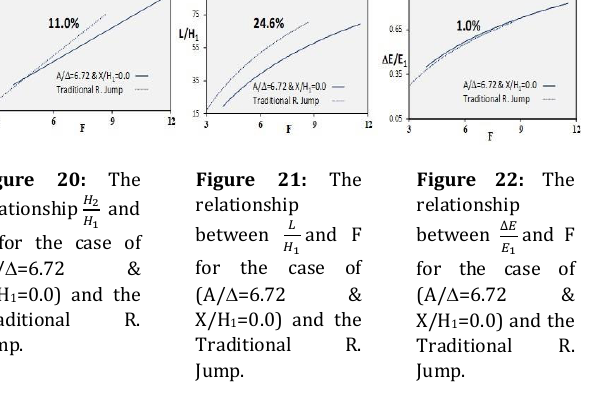
Figure 27: The relationship between the residuals’ values versus the statistical training comparative length of the free H. jump Eq. (3).